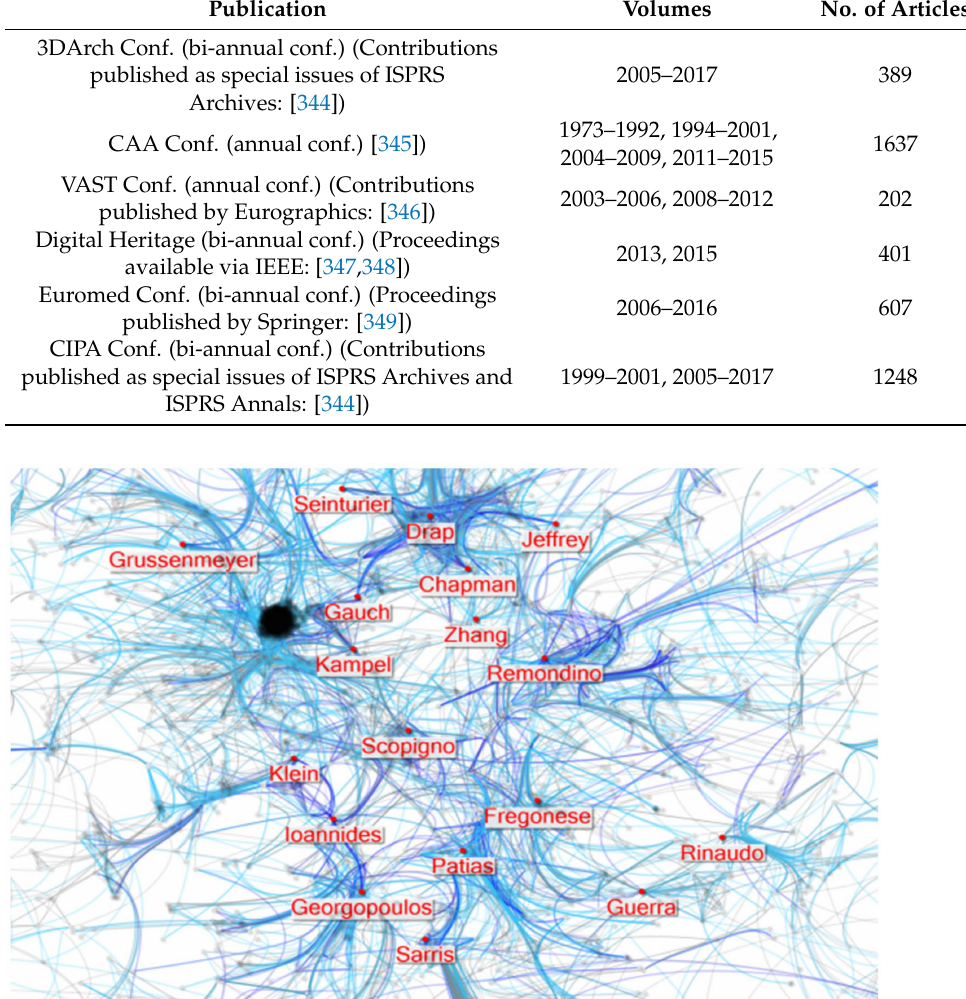
Figure 8. Author-Co-Author Relations ( n = 14,500 links, data from 1990–2015, image cropped, TOP 10 in degree, count, betweenness centrality named, giant component cluster